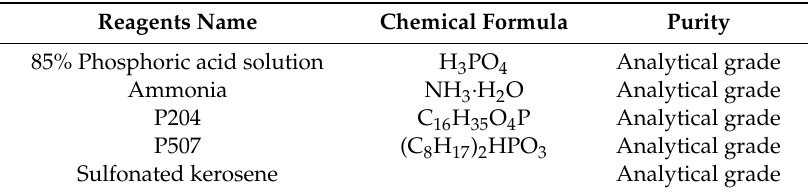
Table 2. Reagents and specification used in the experiments.